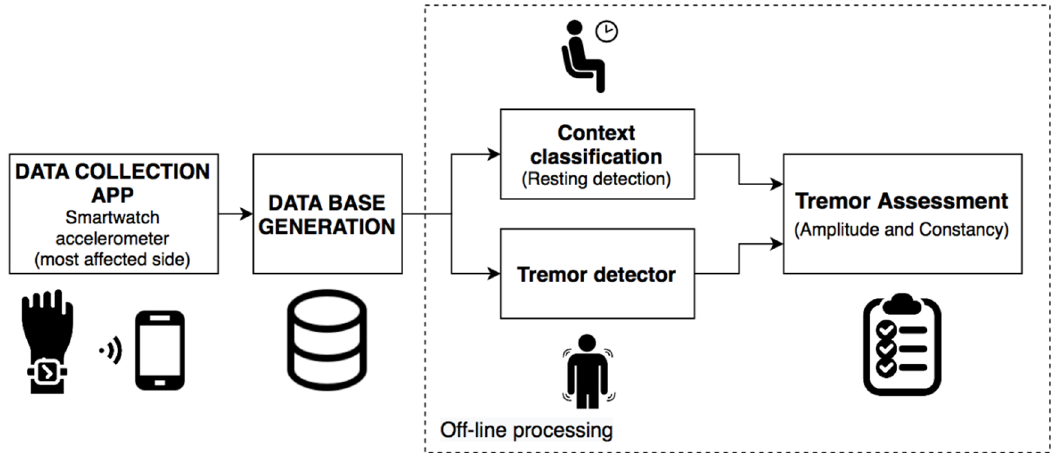
Figure 4. Algorithmic approach for the assessment of resting tremor.